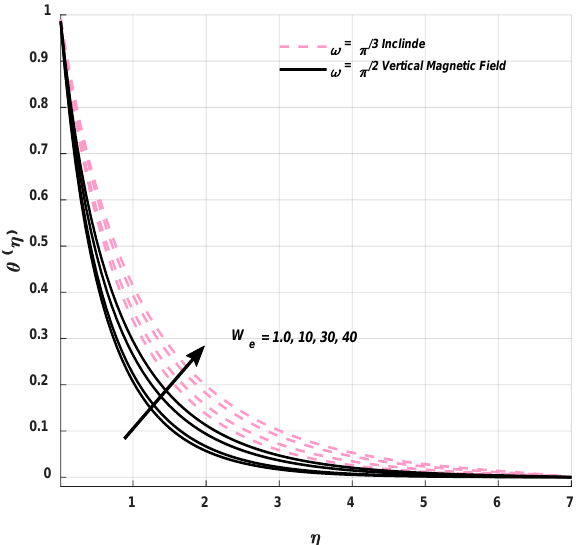
Figure 9. Influence of We on temperature field θ ( η )